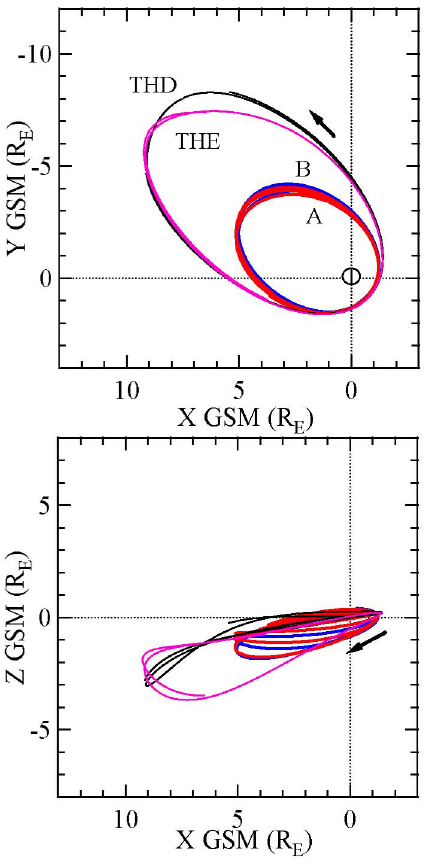
Figure 1. GSM Locations of Van Allen Probes A (in red line) and B (blue line) and THEMIS D (THD; black line) and E (THE; pink line) for the selected interval from 00:00UT on 1 May 2014 to 12:00UT on 2 May 2014.